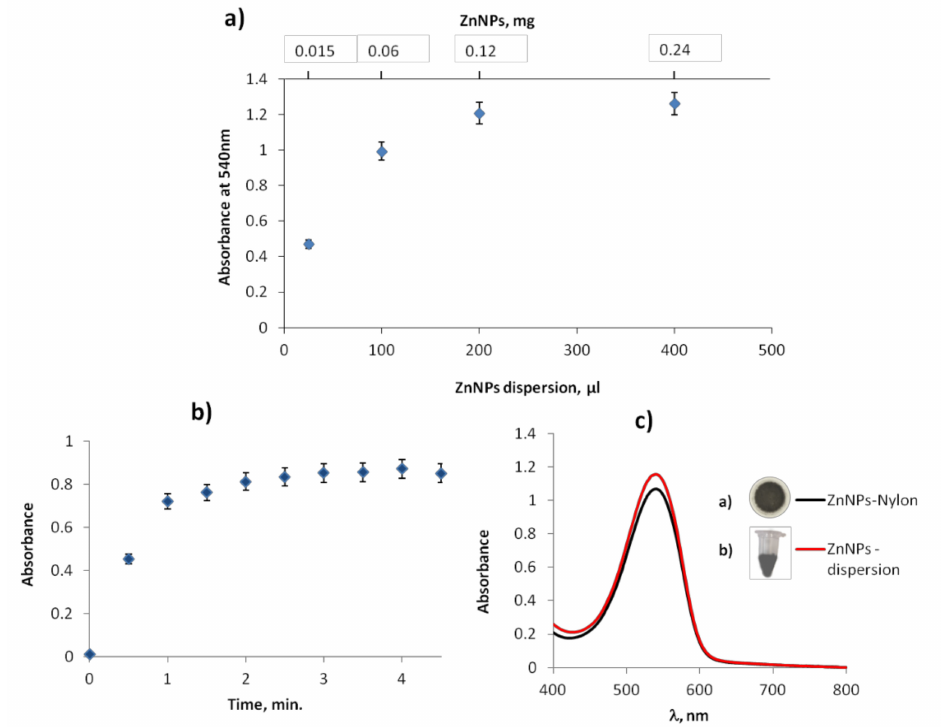
Figure 5. ( a ) ZnNPs amount optimization in the reduction reaction of nitrate (24 mg L − 1 ) to nitrite. ( b ) Reduction reaction time optimization of nitrate (20 mg L − 1 ) to nitrite. ( c ) Analytical responses using ZnNPs-nylon and